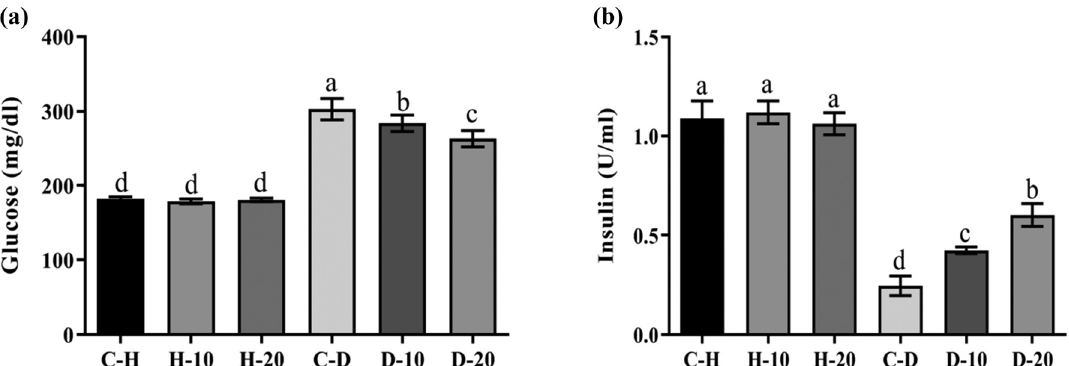
Figure 2: E ff ects of daily administration of NOM on the serum concentrations of glucose ( a ) and insulin ( b ) in diabetic and non - diabetic rats. Di ff erent superscripts ( a – d ) show signi fi cant di ff erences between the groups. The results did not show signi fi cant di ff erences between healthy animals. The administration of the NOM increased insulin and decreased glucose compared with diabetic control in diabetic groups. C – H, H - 10 and H - 20 are healthy rats receiving 0, 10 and 20 mg/kg NOM, while C – D, D - 10 and D - 20 are diabetic rats receiving 0, 10 and 20 mg/kg NOM.